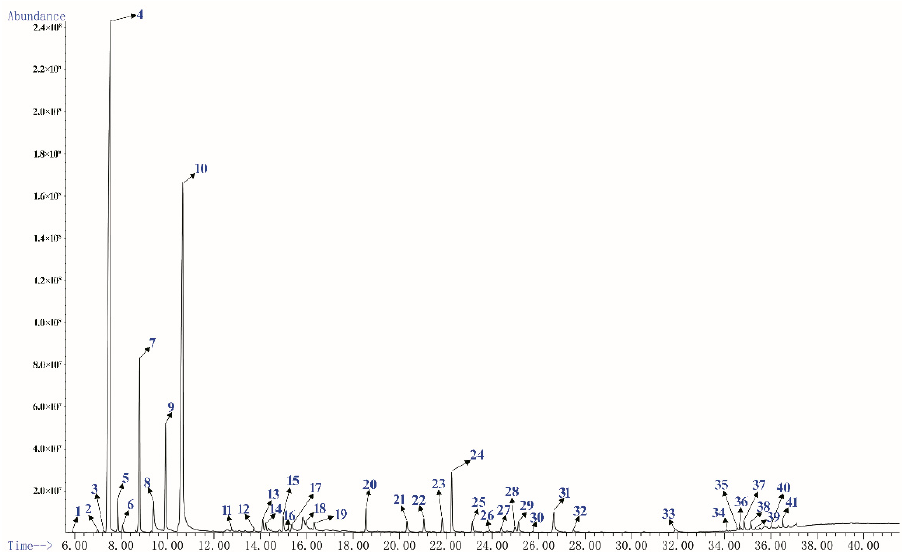
Figure 1. The total ion currency (TIC) profile of